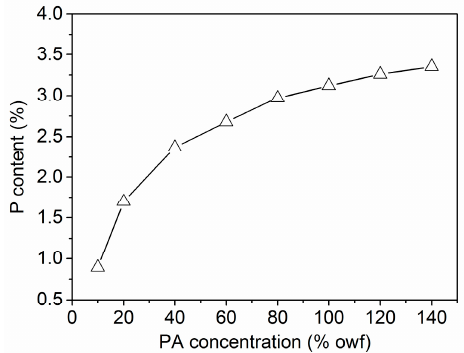
Figure 13. P content of wool fibers determined using SEM-EDS.